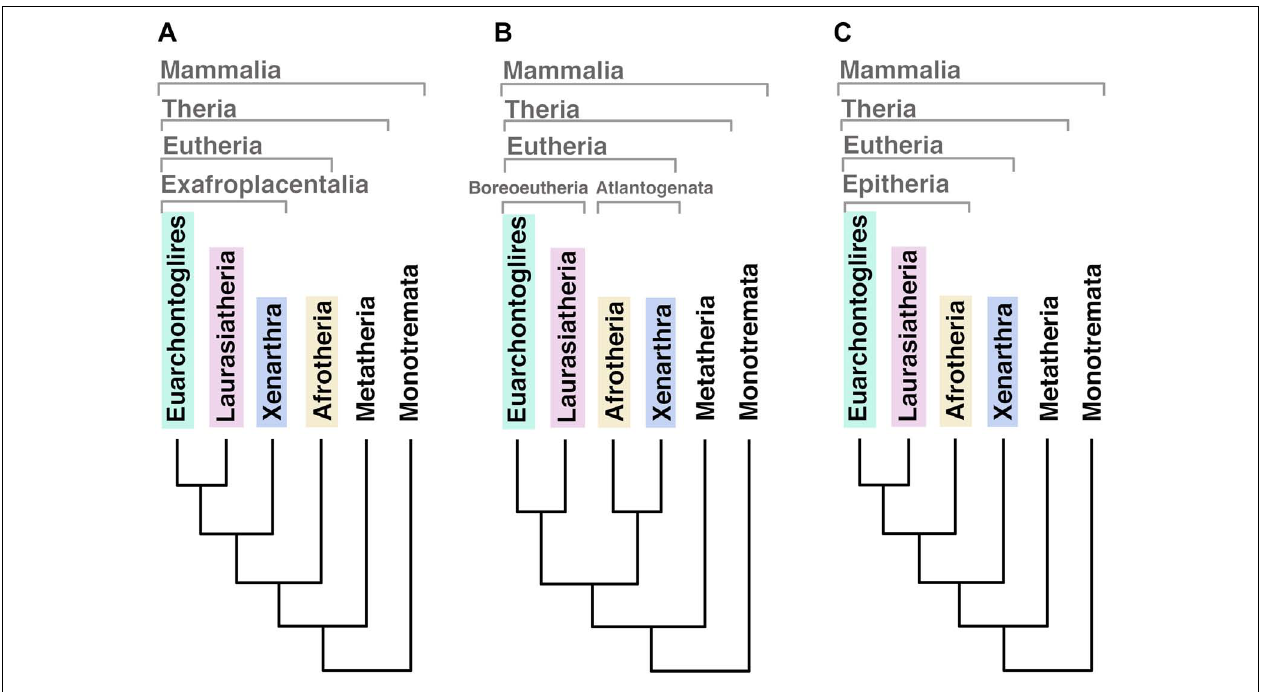
FIGURE 1 | Different outputs for the basal relationships among eutherian mammal superordinal clades. (A) Afrotheria as the most basal mammalian clade, sister lineage of exafroplacentalia (all other eutherians, also called